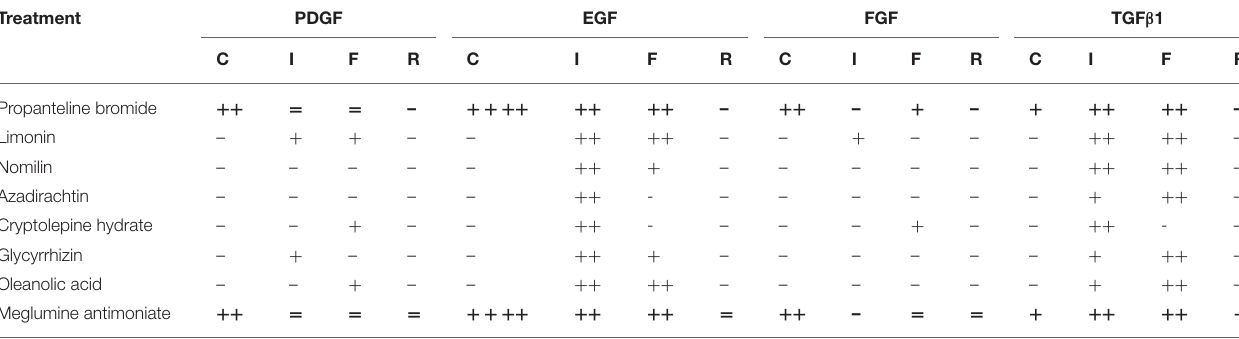
TABLE 2 | Induction of growth factor expression by treatment. Treatment